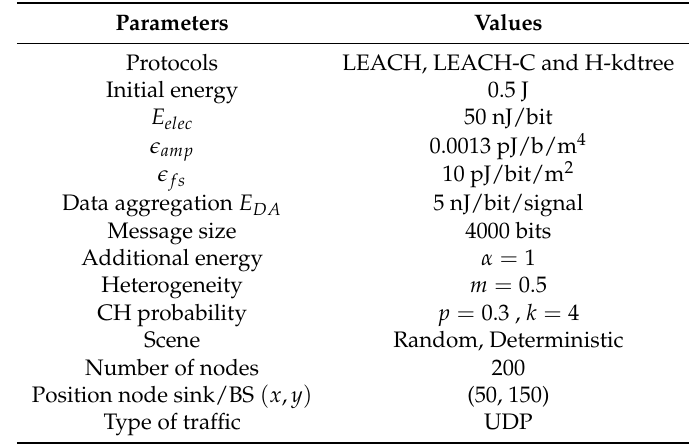
Figure 10. Evaluated scenarios. Table 2. Simulation